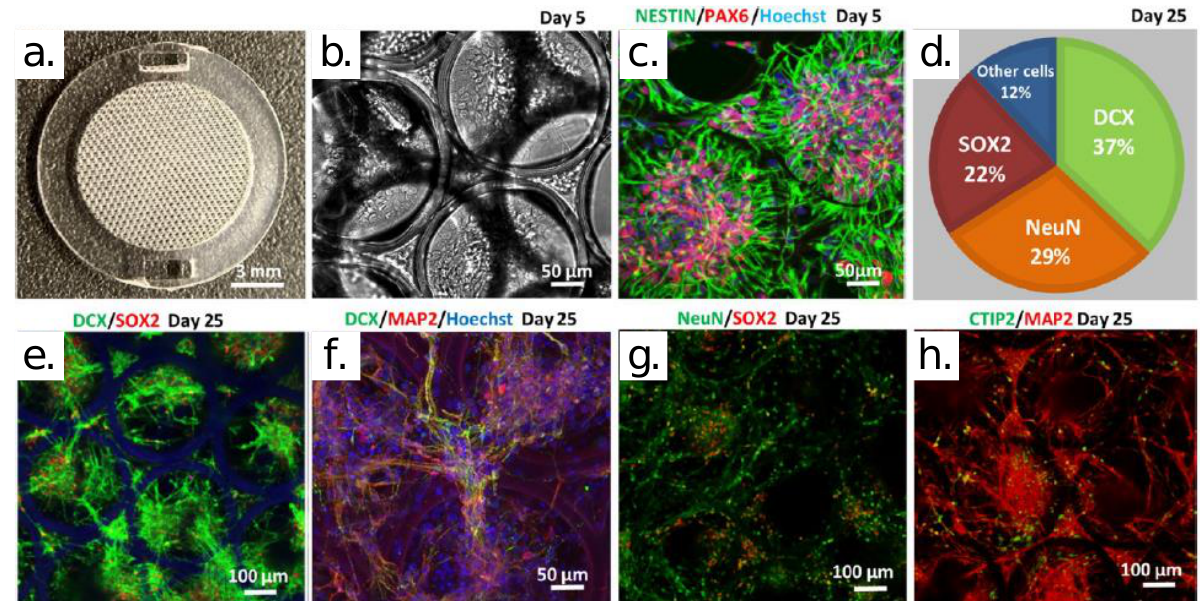
Figure 18. Generation of a 3D neuronal cell culture using laser-fabricated scaffolds. ( a ) General view of the scaffold structure (”honeycomb”) used for 3D neuronal culture development. ( b ) Phase-contrast image showing uniformly distributed cells within the scaffold 5 days after seeding. ( c ) Immunofluorescence image depicting well-accommodated NSCs in the pores of the scaffold. The labeled proteins are Nestin and PAX6, characteristic of cortical stem cells. ( d ) Quantitative ratio of young (DCX+) and mature (NeuN+) neurons as well as SOX2+ multipotent neural progenitor cells in the scaffold at day 25 of culture/differentiation. ( e – g ) Expression of young and mature neuronal markers DCX/MAP2/NeuN and SOX2, indicating a healthy formation of a neuronal network. ( h ) Differentiation of early-born CTIP2+ cortical neurons from neural stem cells. Reproduced with permission [153]. Copyright © 2021, American Chemical Society.